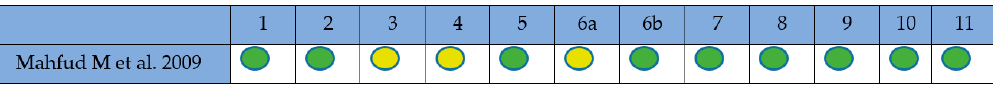
Figure 4. Quality evaluation of case-control study based on CASP checklist. 1. Did the study address a clearly focused issue? 2.Did the authors use an appropriate method to answer their question? 3.